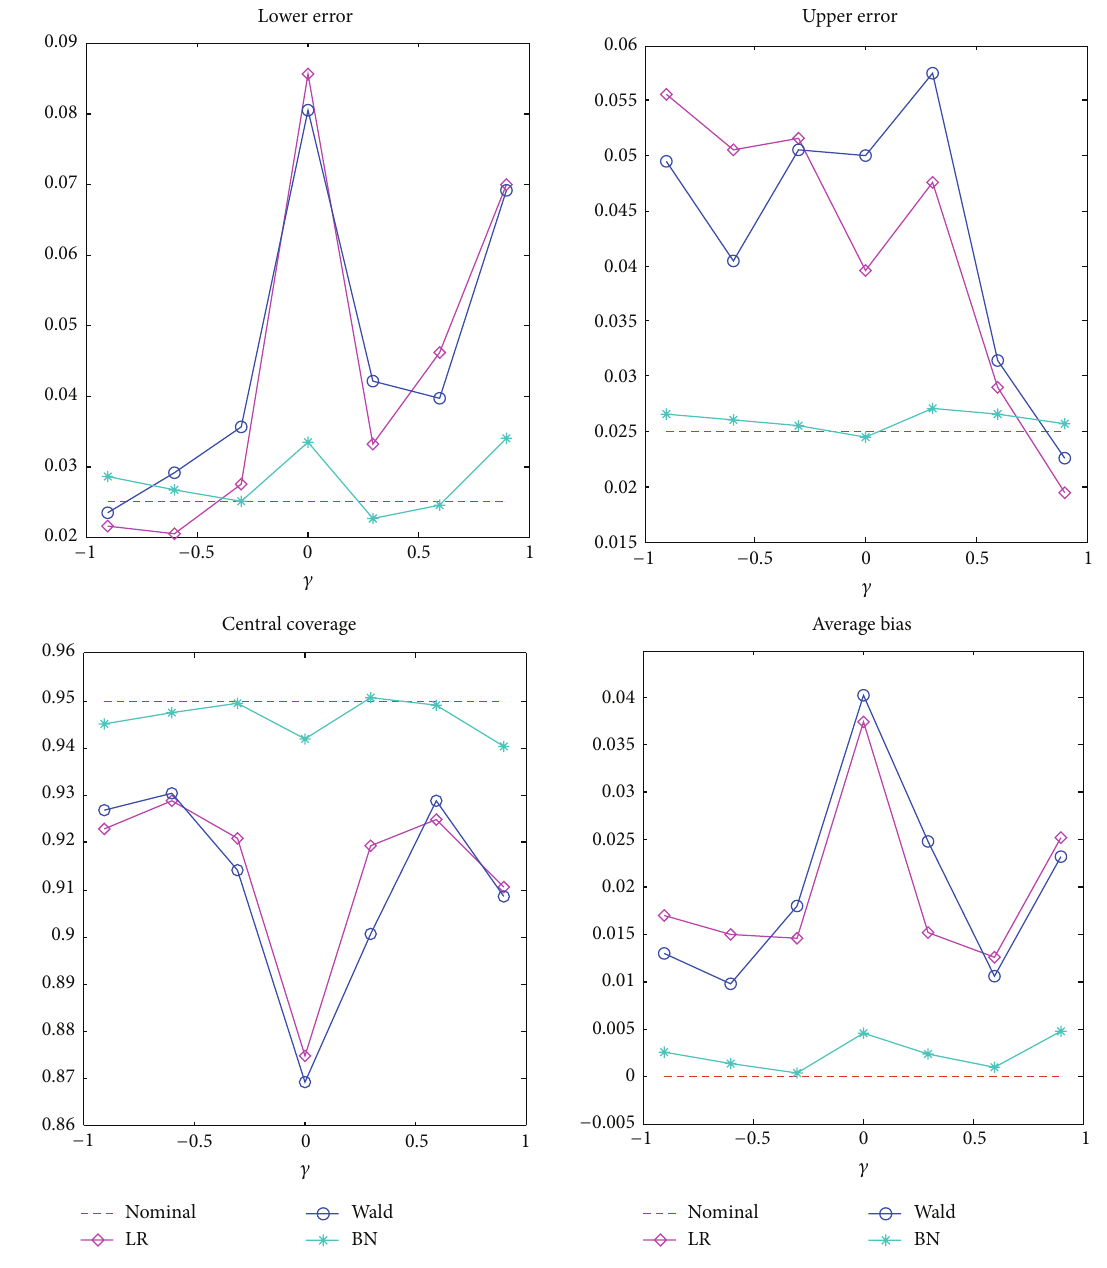
Figure 1: Graphical illustration of the simulation results for 𝑛 = 20 , 95%